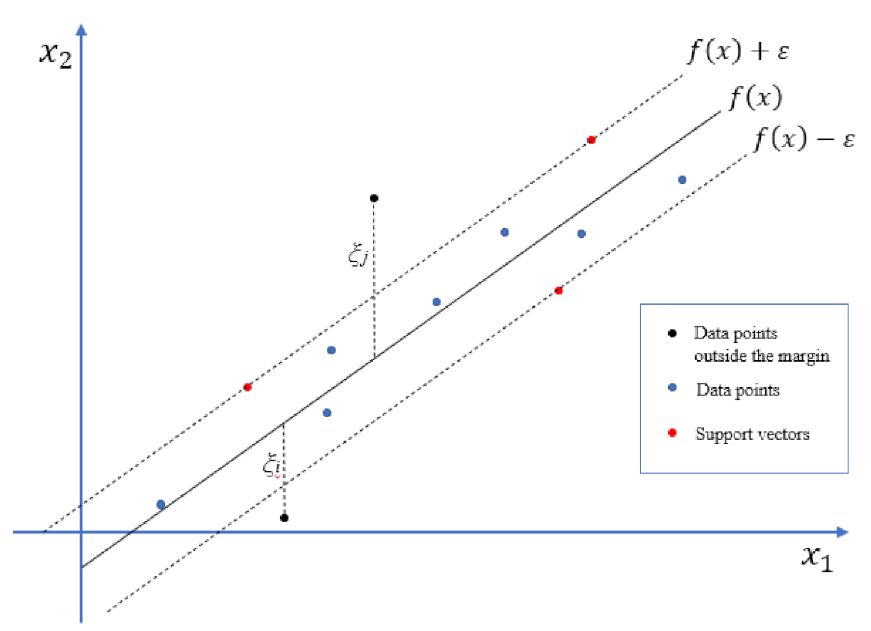
Figure 2. Model graph for support vector